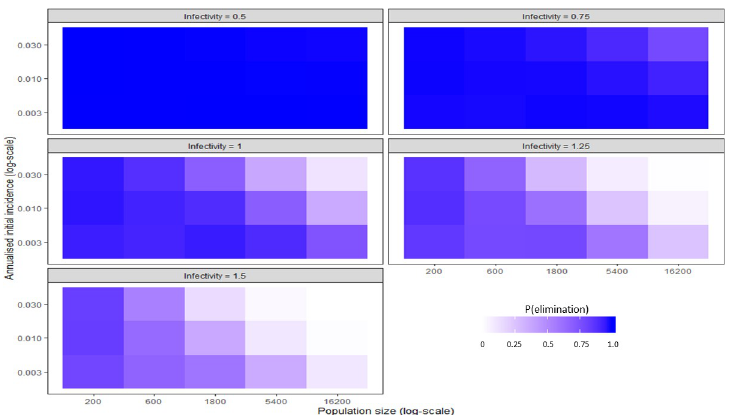
Fig 13. A heatmap showing the effect of population size, infectivity and initial incidence on P(elim.) at 30% herd